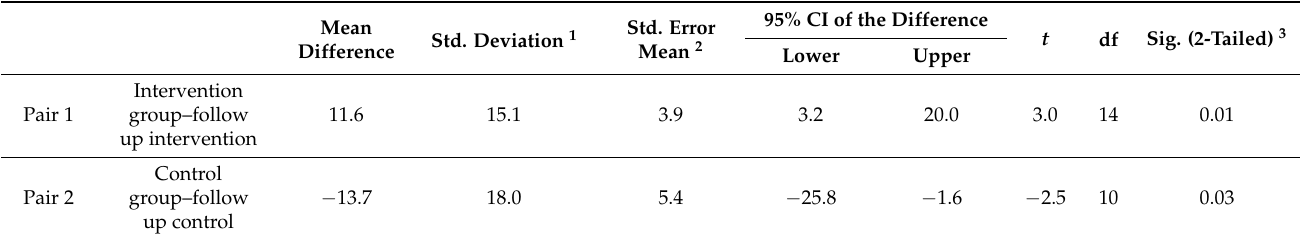
Table 4. Paired samples